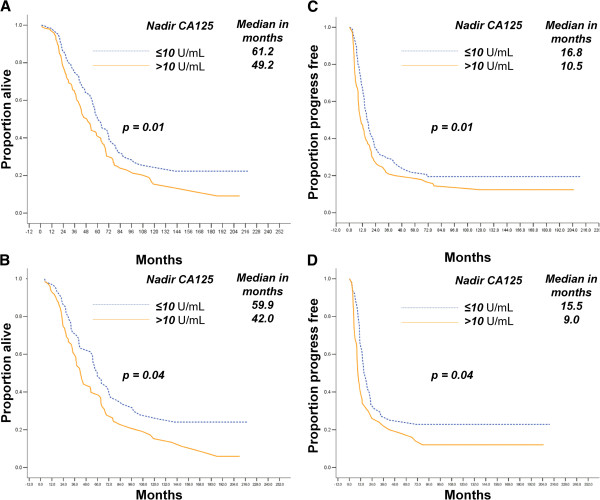
Nadir CA-125 level is associated with OS (A, B) and PFS (C, D) in HG-SOCs from the MDACC (A, C) and JICR (B, D) groups.